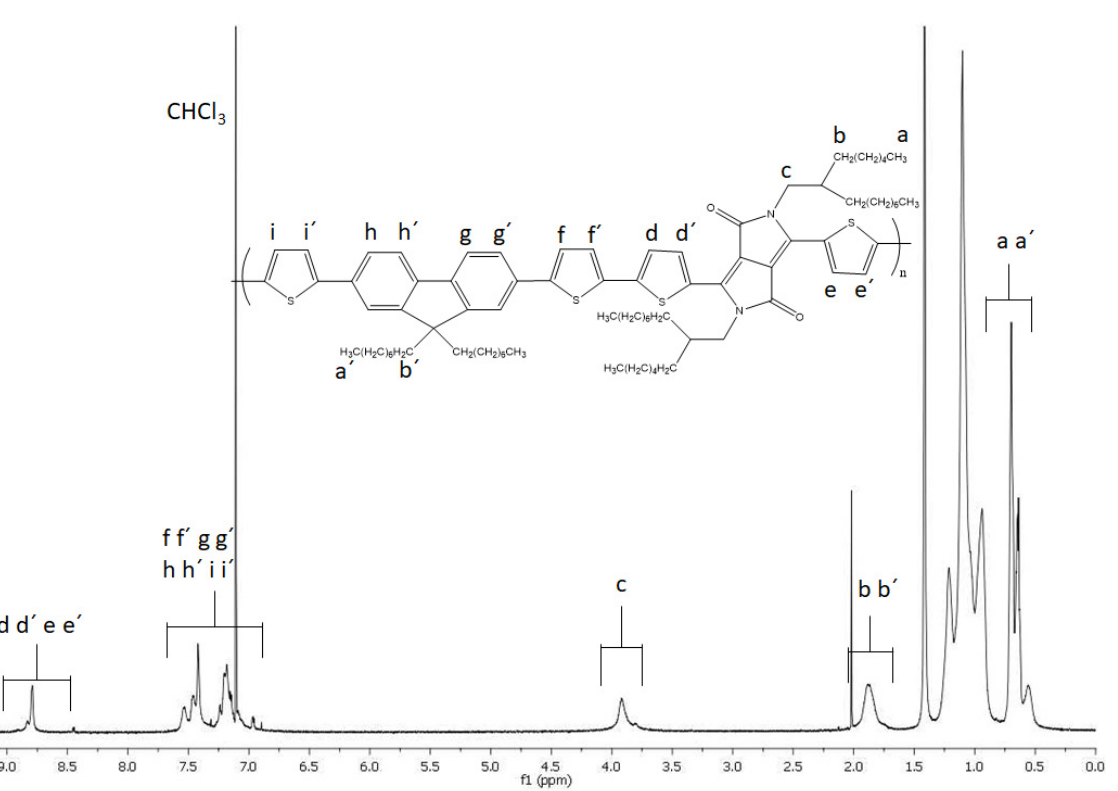
Figure 2. 1 H NMR spectra of PFDPP-1 in CDCl 3 (Each letter corresponds to the signal of its respective hydrogen).